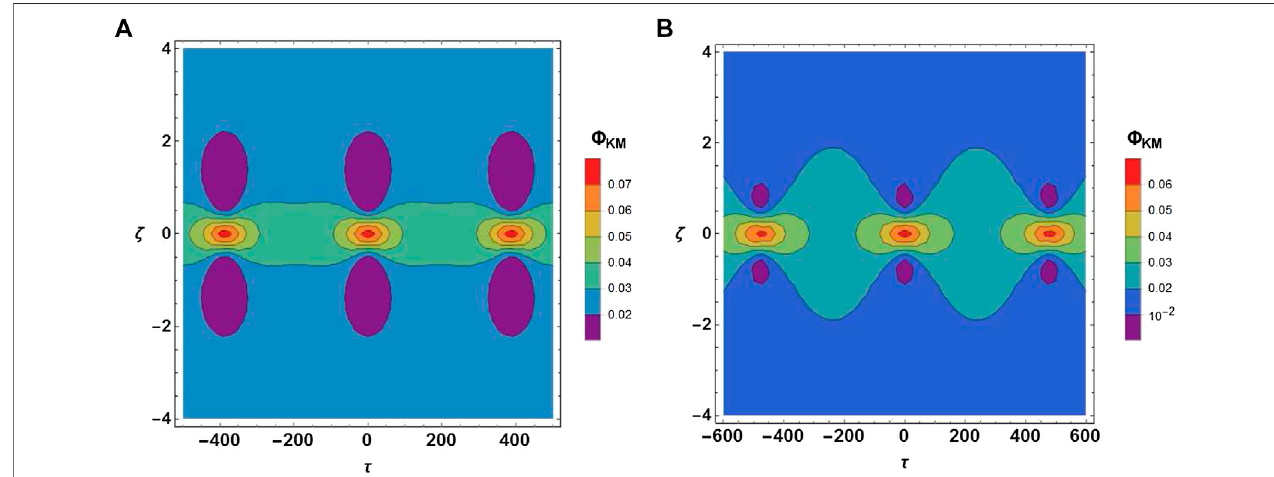
FIGURE 6 | The variation of DA Kuznetsov – Ma breather pro fi le in ζ - τ plane (A) for α (cid:1) 0 . 2 and (B) α (cid:1) 0 . 3 at fi xed values of R (cid:1) 0 . 11 and ρ (cid:1) 1 . 11.